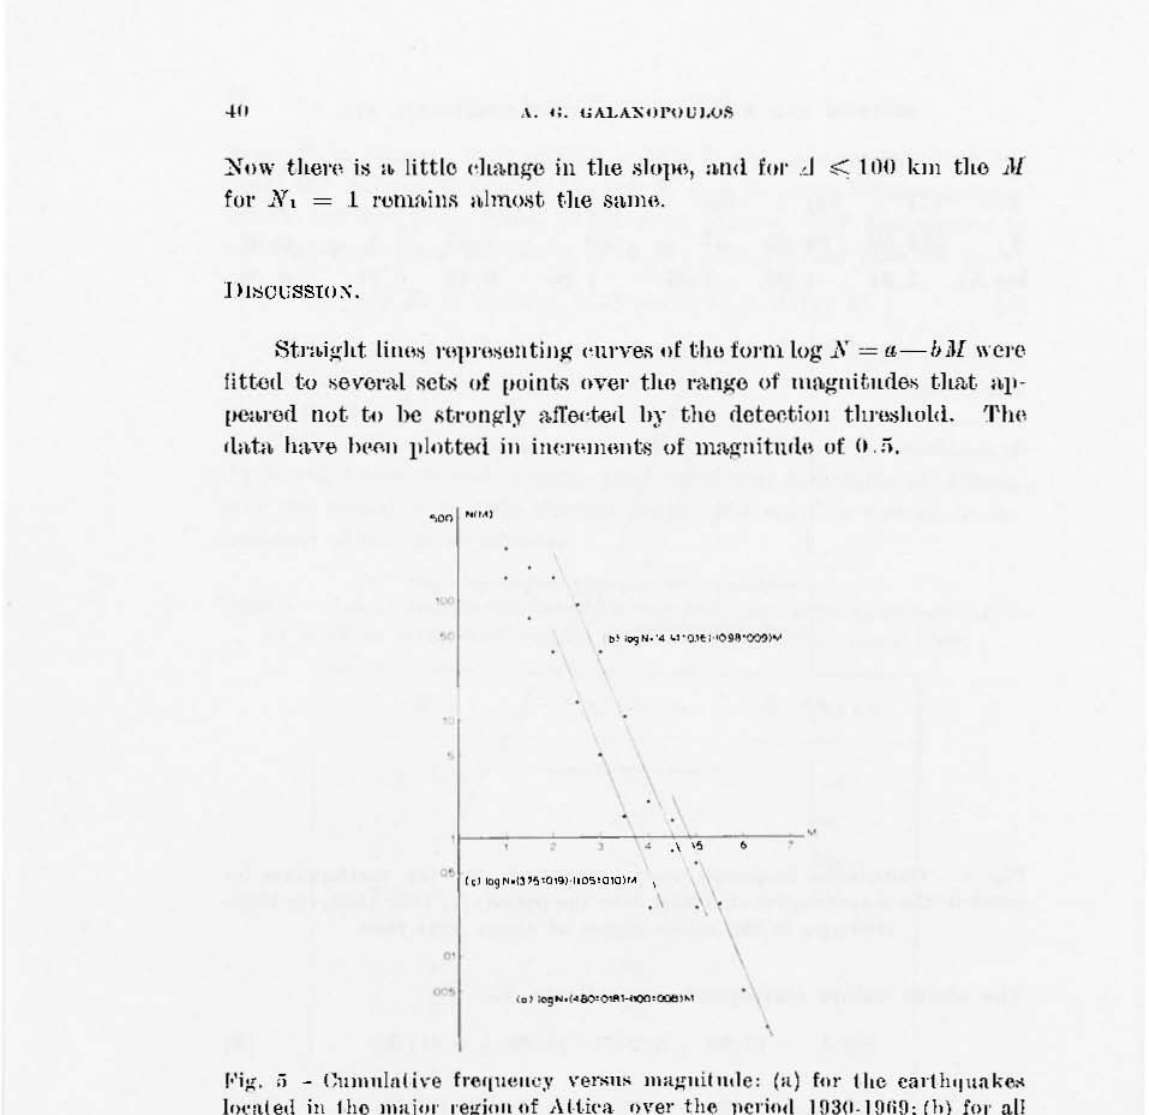
Fig. " - 1 ~1ll1ll1nlh·e fre'luI:lh:.\' \"en;m' mag llil thlC: (a) Inr lite c:lJ"l h'p!a